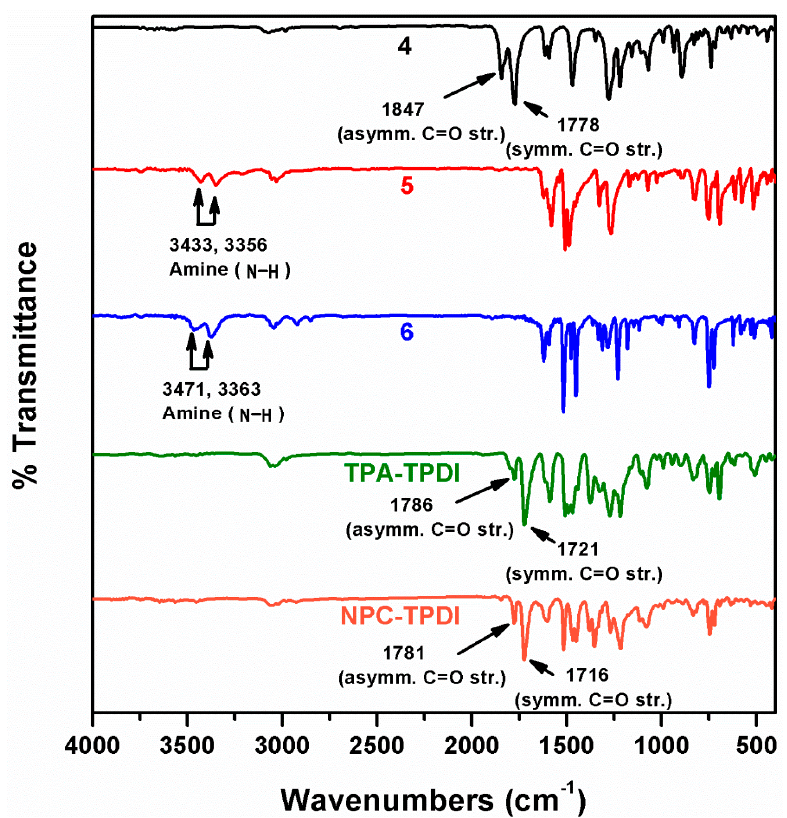
Figure 5. Infrared (IR) spectra of compounds 4 , 5 , 6 , TPA–TPDI and NPC–TPDI.